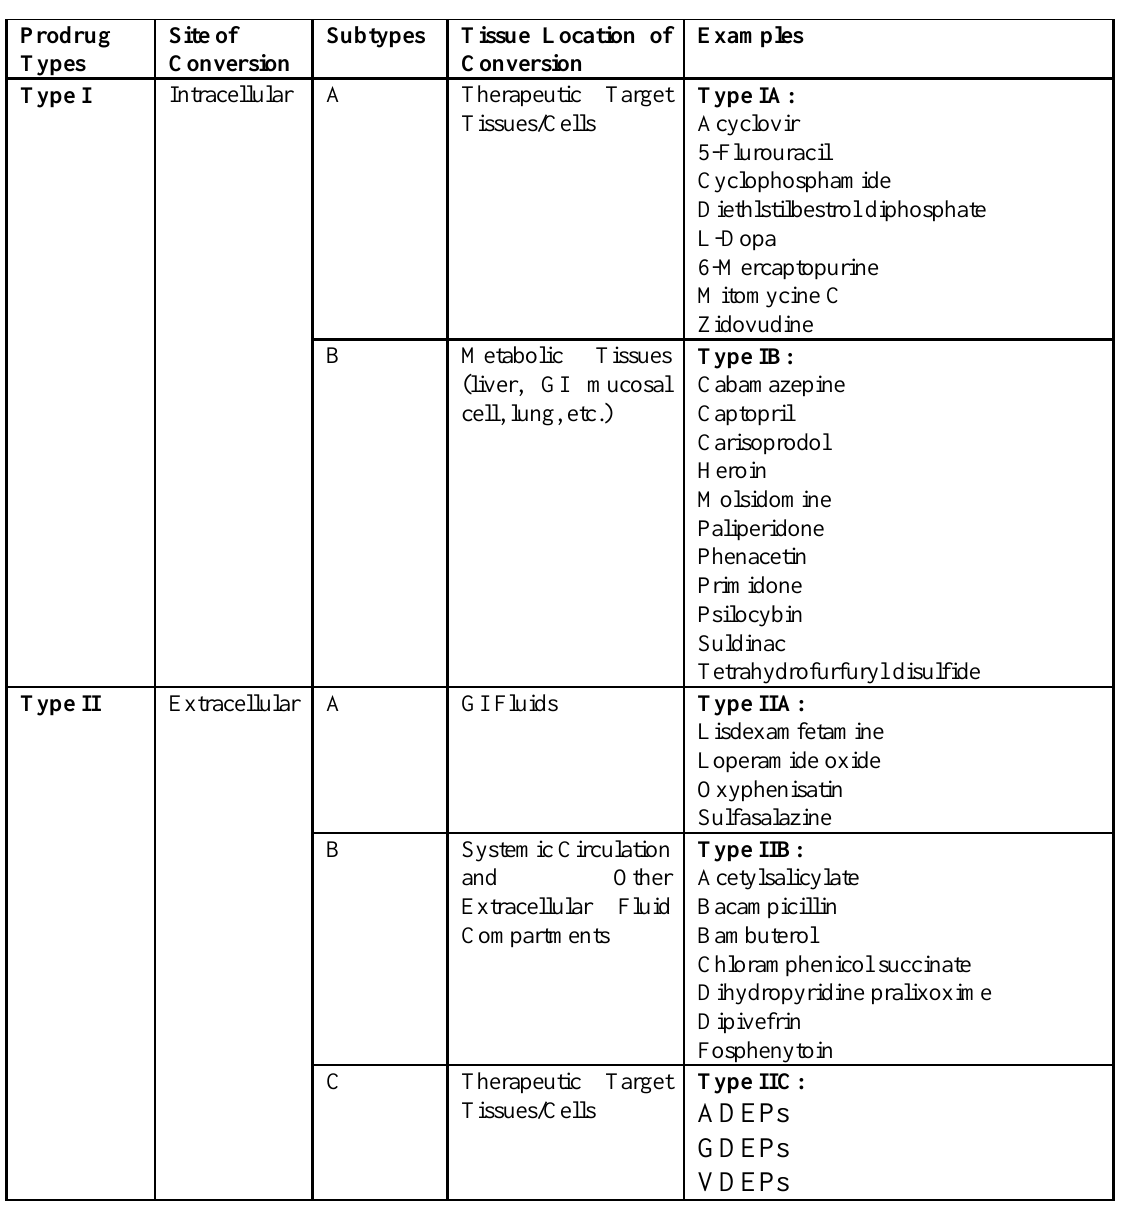
Table 1. Classification of